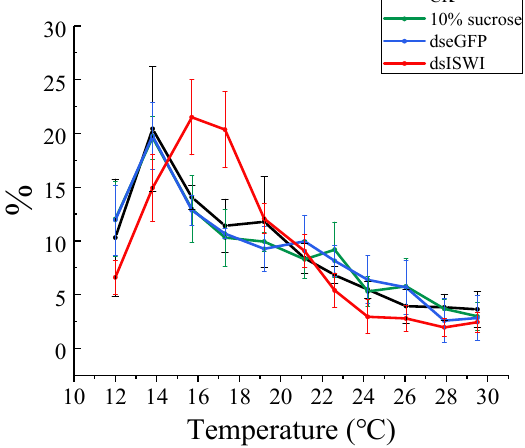
Figure 8. Temperature preference response of MEAM1 adults. The number of whiteflies in each biological replicate was 200, and there were four repetitions for each treatment. Compared to the control treatments (whiteflies untreated, or fed dseGFP or 10% sucrose), whiteflies fed dsISWI showed a higher preferred temperature and a wider distribution range of favorable temperatures. The data are presented as the mean ±